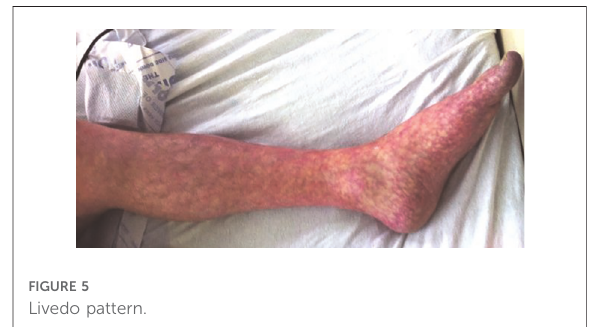
FIGURE 5 Livedo